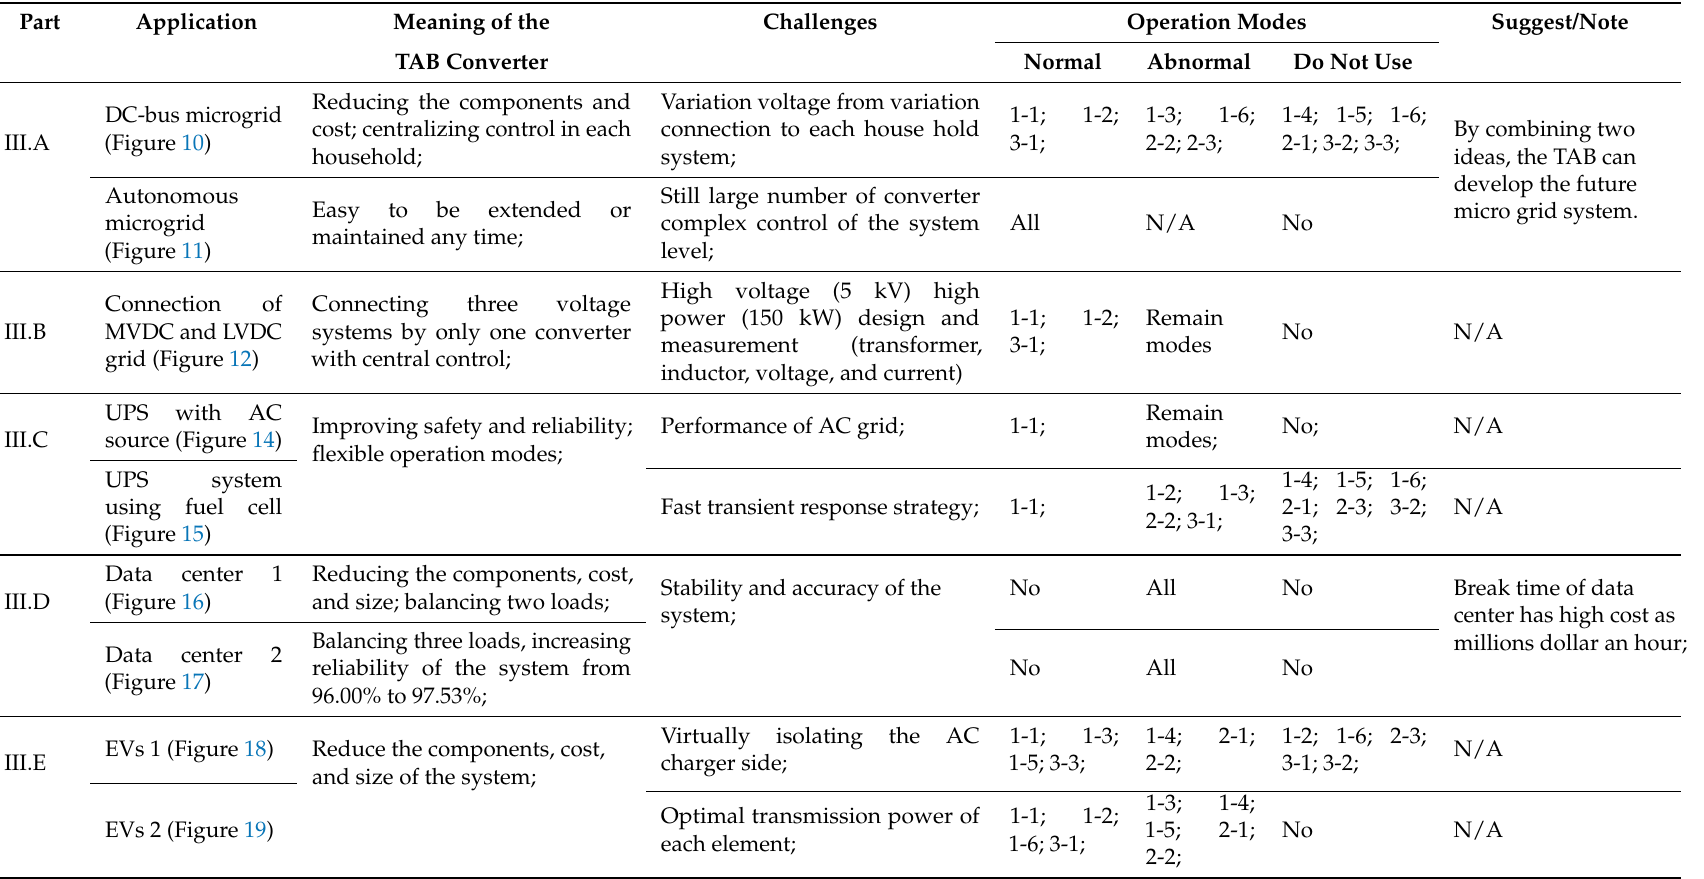
Table 1. Summary the characteristics of applications of TAB